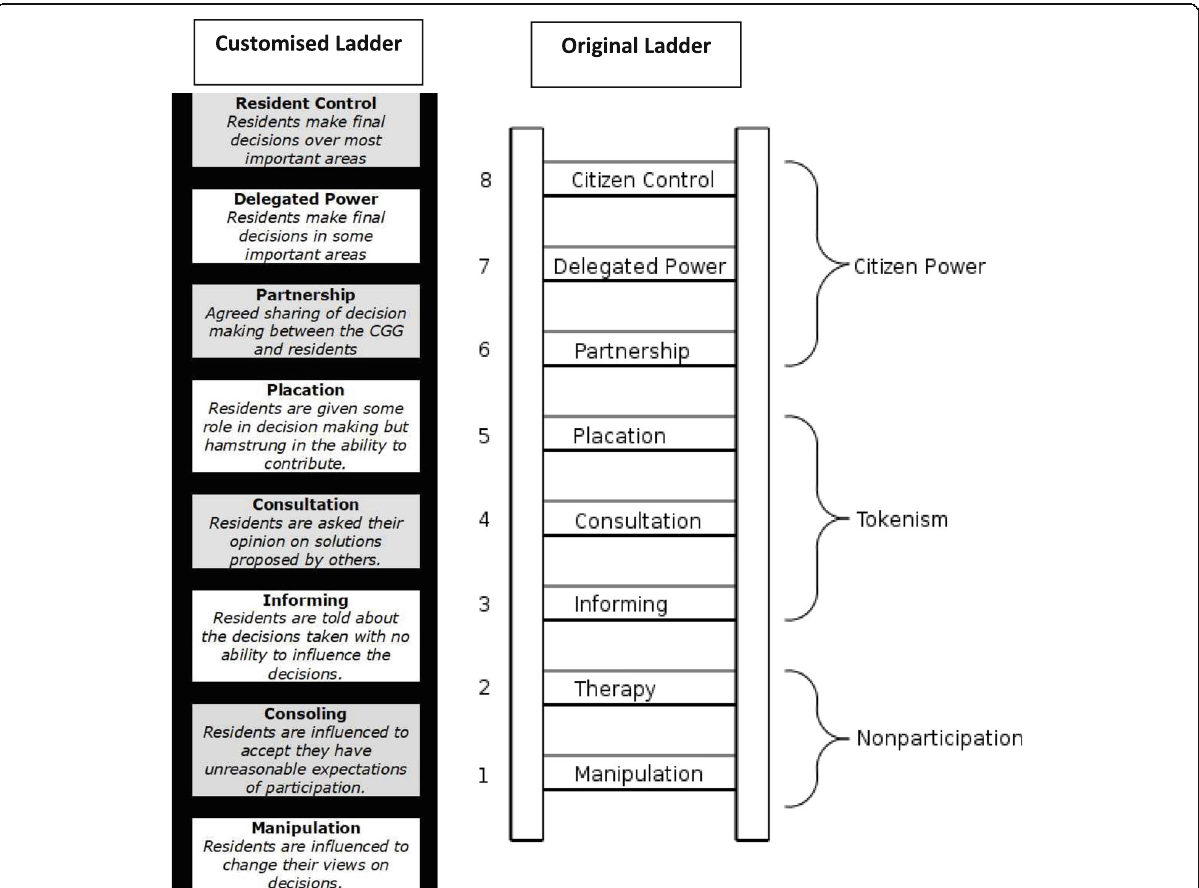
Fig. 1 customisation of the Arnstein Ladder in the CGG side-by-side with Arnstein ’ s Original Ladder